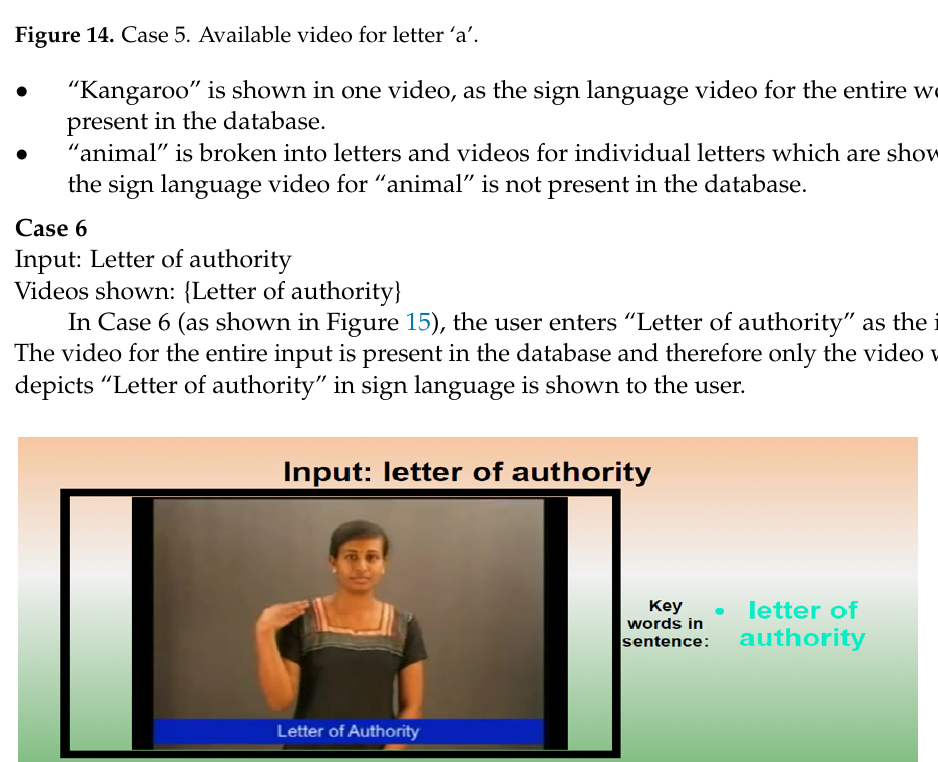
Figure 14. Case 5. Available video for letter ‘a’.